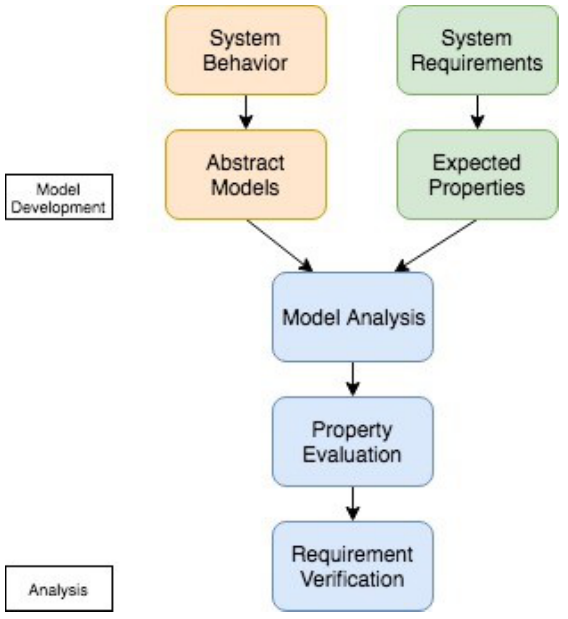
Figure 1. Model-based engineering